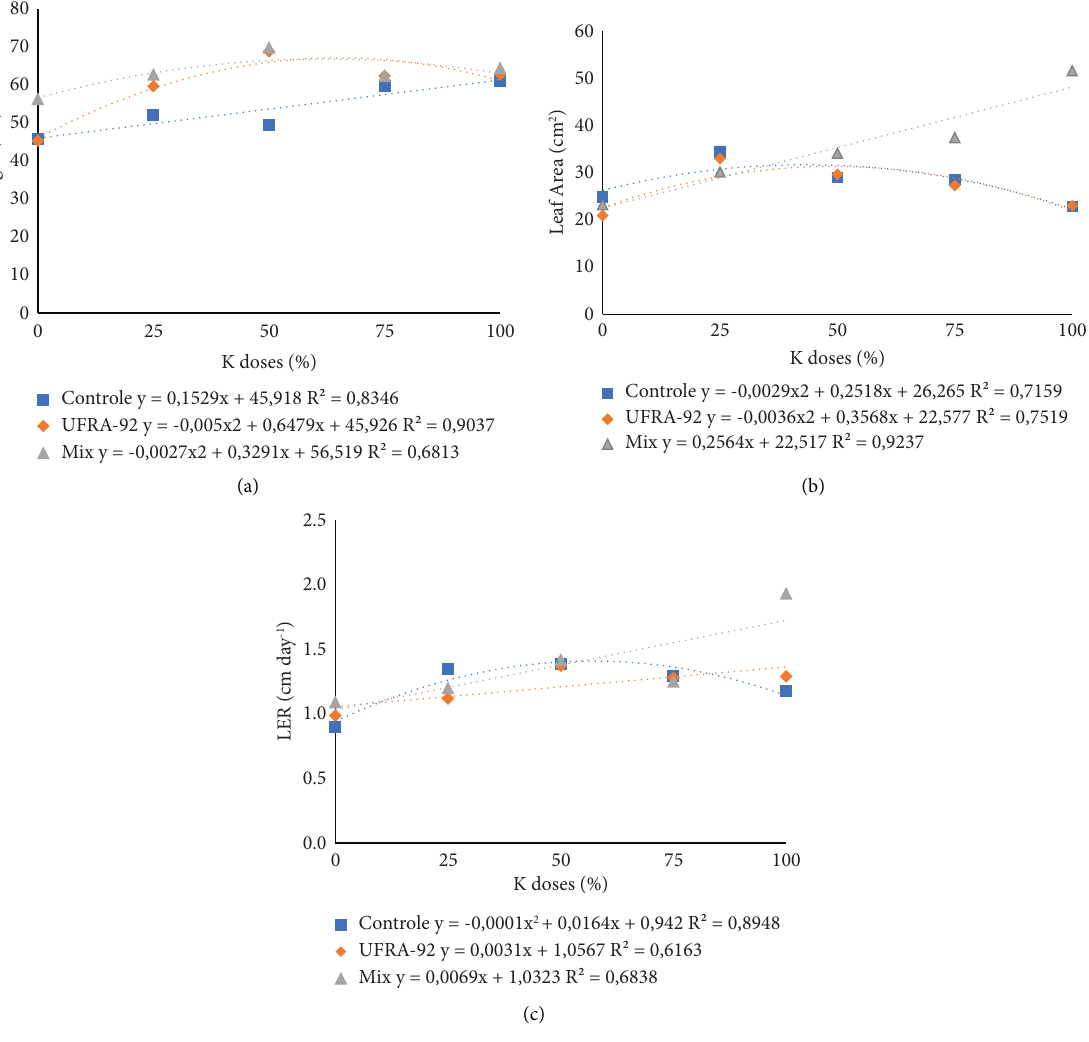
Figure 3: Efect of inoculation with Bacillus subtilis (UFRA-92) and Trichoderma asperellum +UFRA-92 (MIX) as a function of potassium doses on height (a), leaf area (b), and leaf elongation rate (c) of Urochloa brizantha cv.